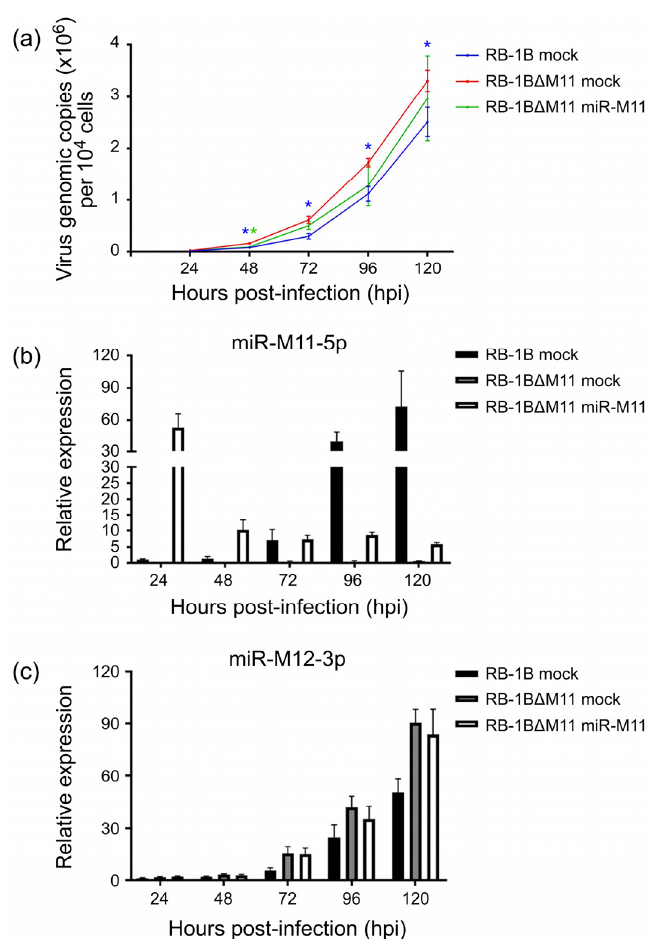
Figure 6. In vitro proliferation of the RB-1B mutant viruses with miRNA-deletions. Viral genomic copies of the parental or mutant viruses per 10 4 cells, estimated based on MDV-1 US2 gene, were determined by a real-time qPCR on DNA from virus-infected CEFs sampled at different time points post-infection. All the experiments were repeated in triplicate. Asterisk (*) indicates statistically significant differences between miR-KO mutant virus and parental RB-1B at different time points. *, p < 0.05.